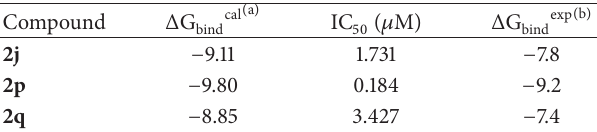
Table 2: Calculated binding free energies in comparison with available experimental data (all in